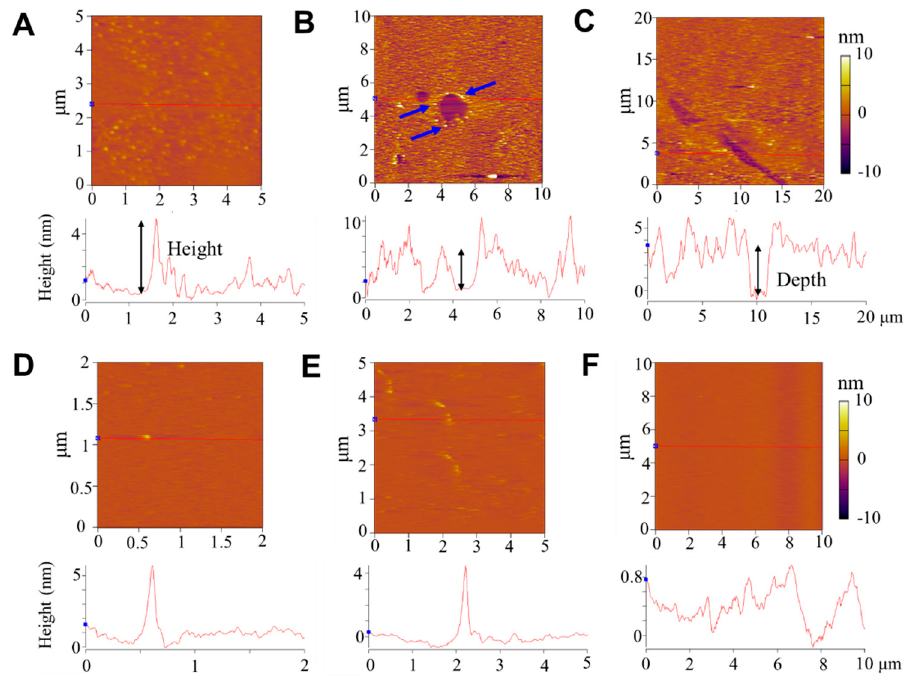
Figure 4. Representative AFM topographies of SLBs after AS4-5 ( A – C ) or AS4-1 ( D – F ) incubation. The images in ( A – F ) represent different membrane regions. The orange background refers to the SLB surface. Corresponding height profiles are shown at the bottom. The membrane, composed of PC, was incubated with peptides at 2.0 µ g mL − 1 for 40 min under a low-ionic-strength and neutral-pH condition before characterization. Blue arrows in ( B ) emphasize the raised edge of the hole. Black arrows represent the height or depth of corresponding structures.